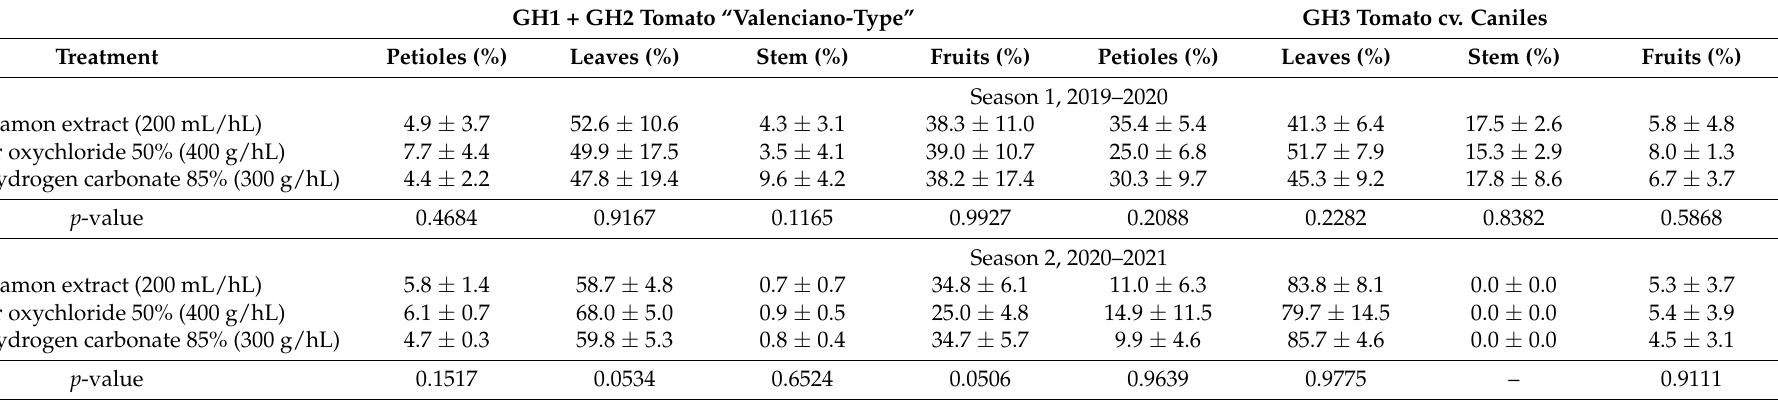
Table 3. Relative incidence of grey mould symptoms on different locations of “Valenciano-type” and cv Caniles tomato plants for Season 1 and Season 2 depending on treatment. Percentages based on the final accumulated symptoms recorded per location in the whole plots.